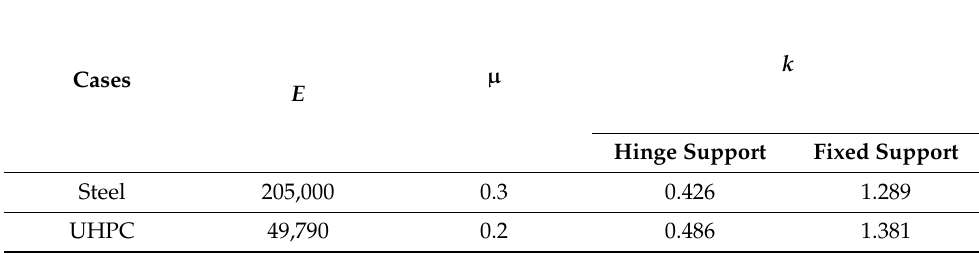
Figure 6. Comparison of elastic local buckling coefficient ( k ) for UHPC and steel .